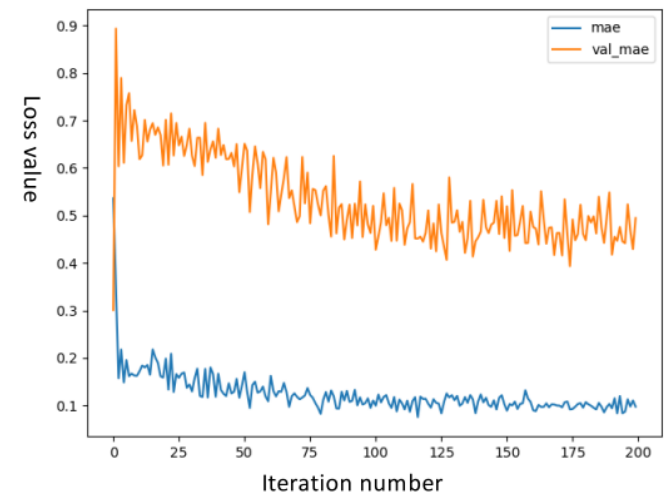
Figure 8. MAE on the training and validation sets.